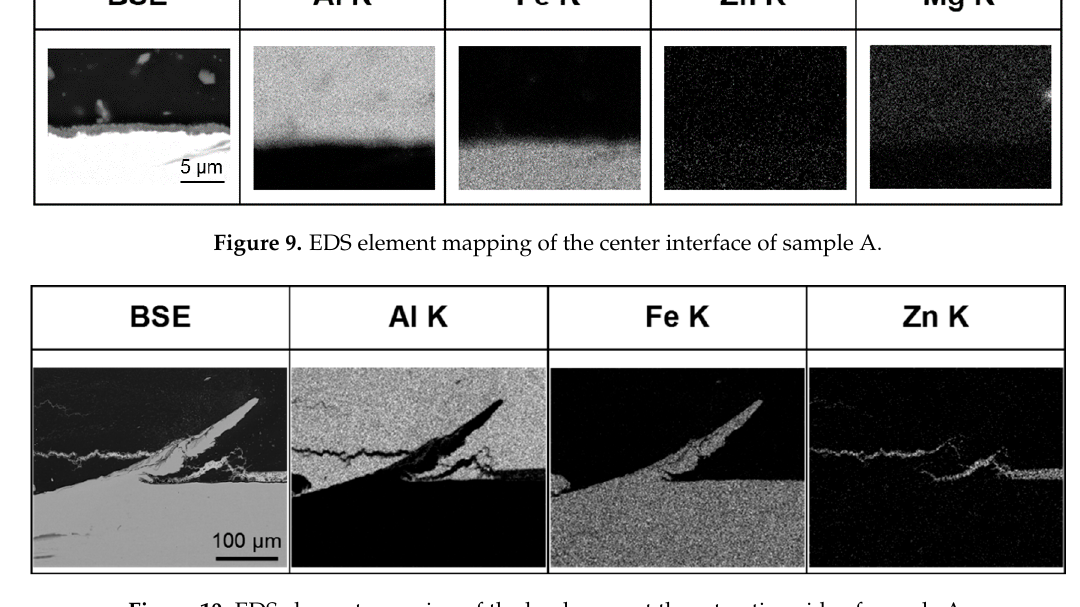
Figure 10. EDS element mapping of the hook zone at the retreating side of sample A.